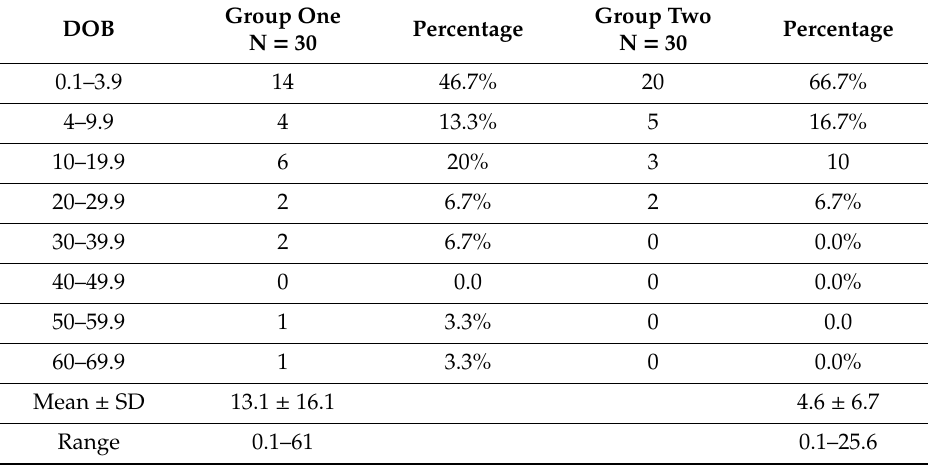
Table 5. Delta over baseline (DOB) for patients in diagnosis and post-eradication